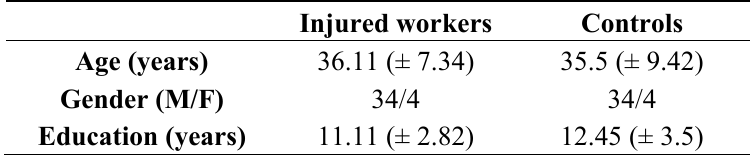
Table 1. Mean values ( ± S.D.) of socio-demographic data in injured and control